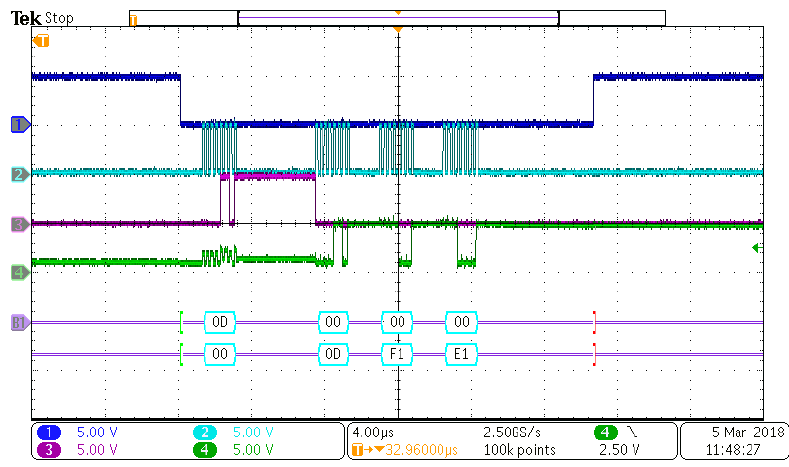
Figure 11. Communication between ADE7758 IC and ATMega328P when the V RMS register is read (Ch1. SS, Ch2. SCLK, Ch3. MOSI, Ch4. MISO).